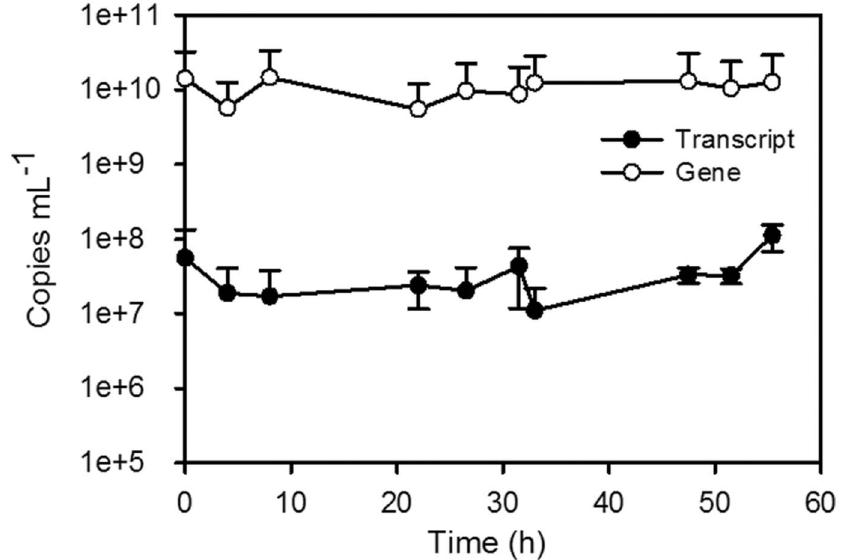
Figure 4. Representative figure of data used to obtain transcript-to-gene ratios. act all-dark transcript and gene copies per mL of sample were calculated via absolute quantification using external calibration curves. Error bars represent the standard deviation derived from triplicate qPCRs from biological replicates.